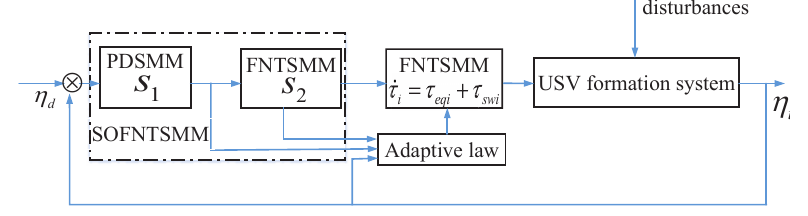
Figure 2. Block diagram of the scheme of the ASOFNTSMC for USV